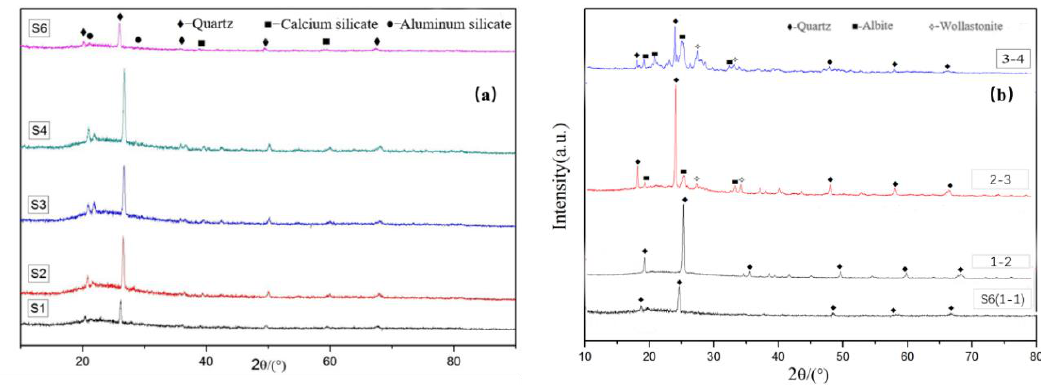
Figure 10. ( a ) XRD patterns of the foam ceramics with different tailing contents; ( b ) XRD patterns of the S6(1-1), 1-2, 2-3, and 3-4 samples.